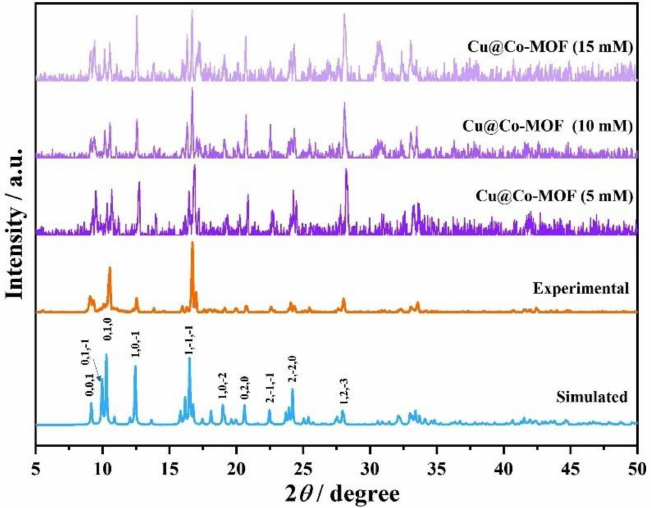
Figure 2. The experimental XRD patterns of Co–MOF and